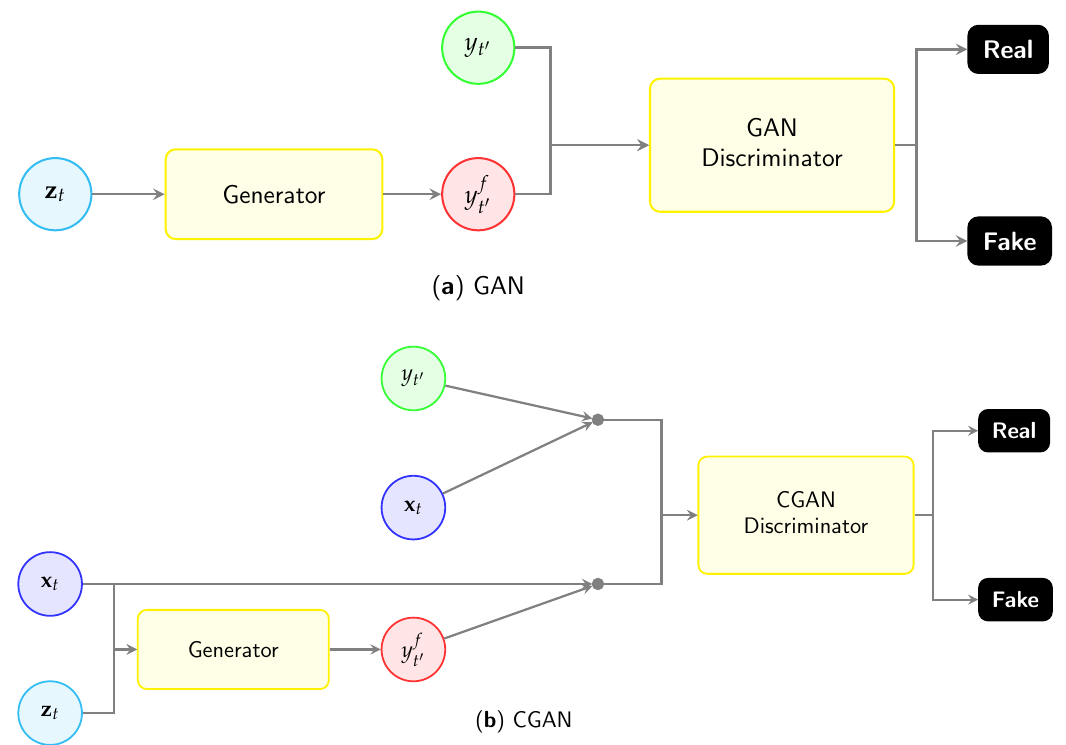
Figure 1. Schematic of ( a ) GAN and ( b ) CGAN models, showing Generator and Discriminator components and associ- ated